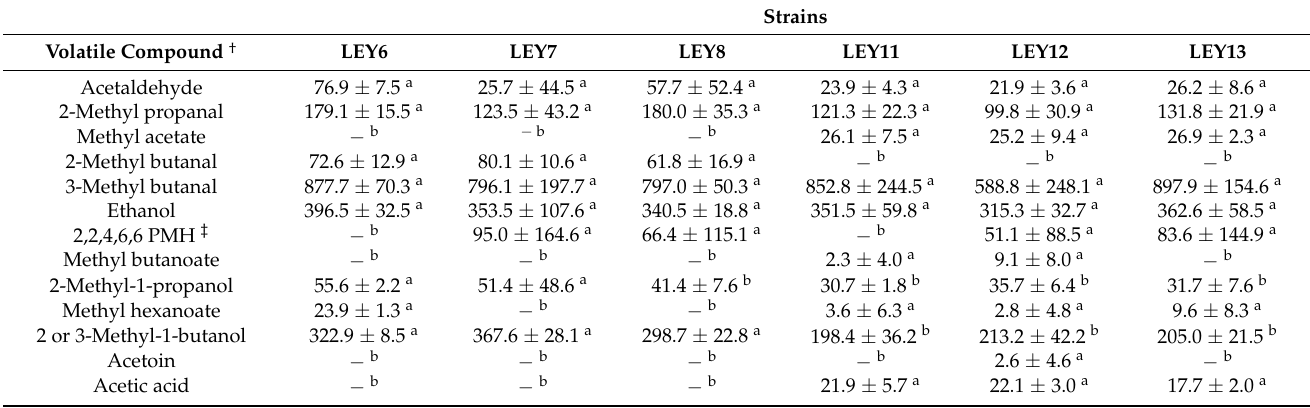
Table 4. Volatile compounds produced by the L. lactis isolates during growth at 30 ◦ C for 24 h in ultra-high temperature (UHT) skimmed milk (HS/GC/MS analysis). Values represent the mean ± the standard deviation of three independent